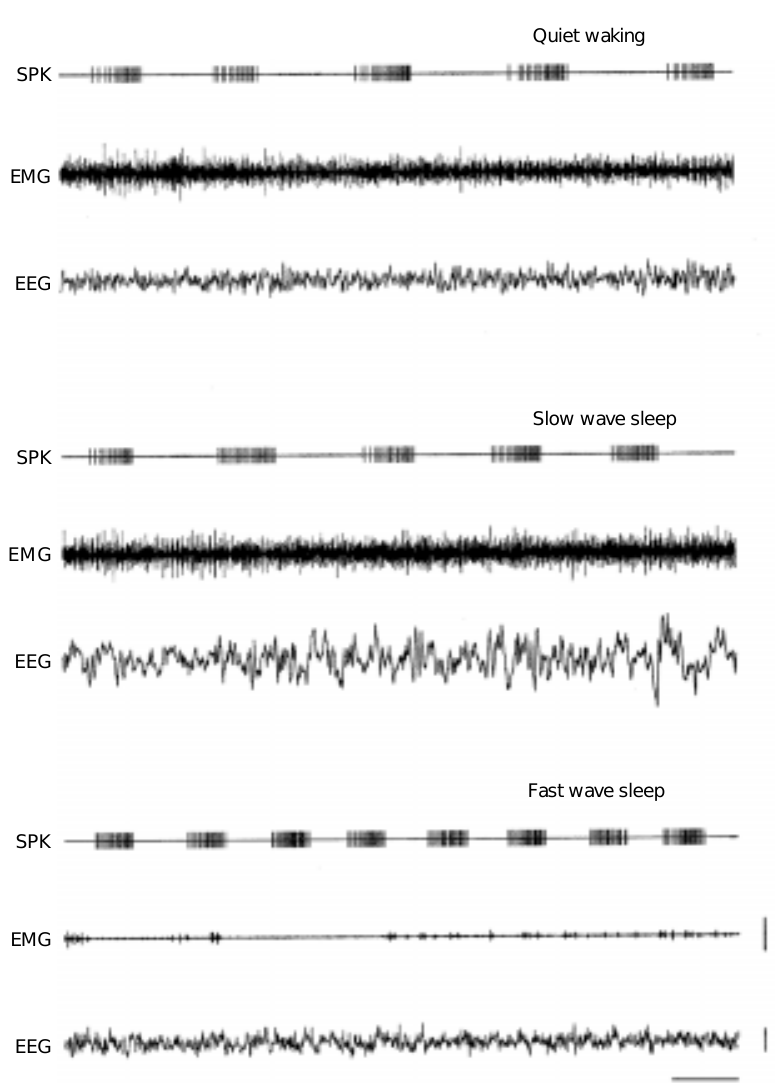
Figure 2. Cyclically changing activity during 10 s of quiet waking, slow wave sleep and fast wave sleep of a non-serotonergic neuron in the nucleus raphe pallidus. Bursts of activity occurred in synchrony with the inspiratory movements of the thoracic cage of the animal. SPK, neuronal activity; EMG, splenius electromyographic activity; EEG, parietal electrocor- ticographic activity. Vertical bars at bottom right represent 100 µV. Horizontal bar at bottom right represents